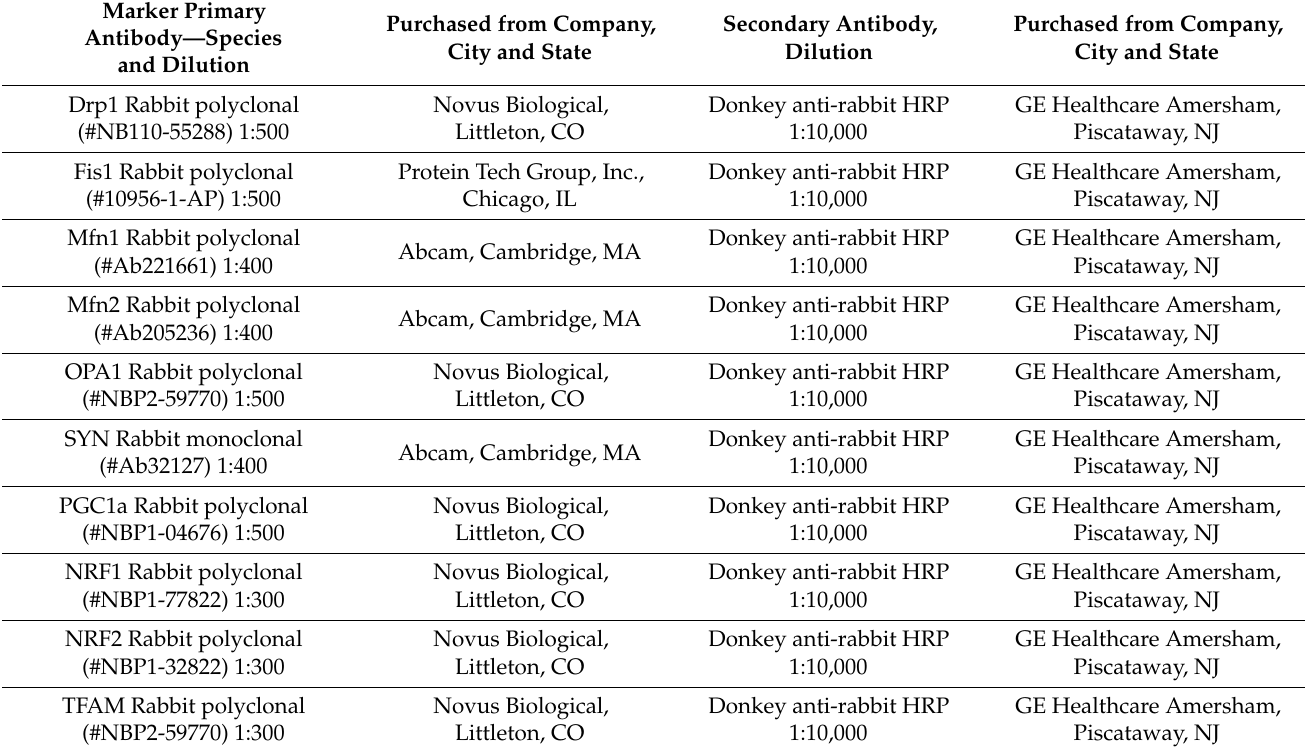
Table 3. Summary of antibody dilutions and conditions used in the immunoblotting analysis